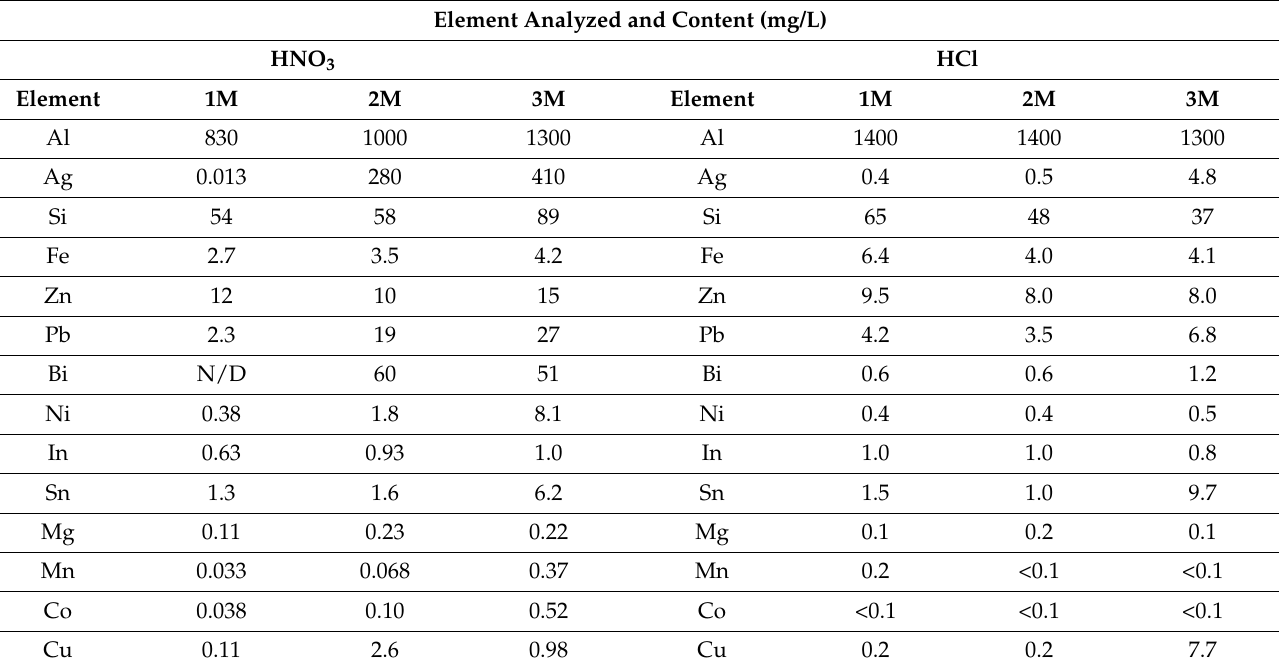
Table 2. ICP-Full Scan of the filtered solution—concentration.